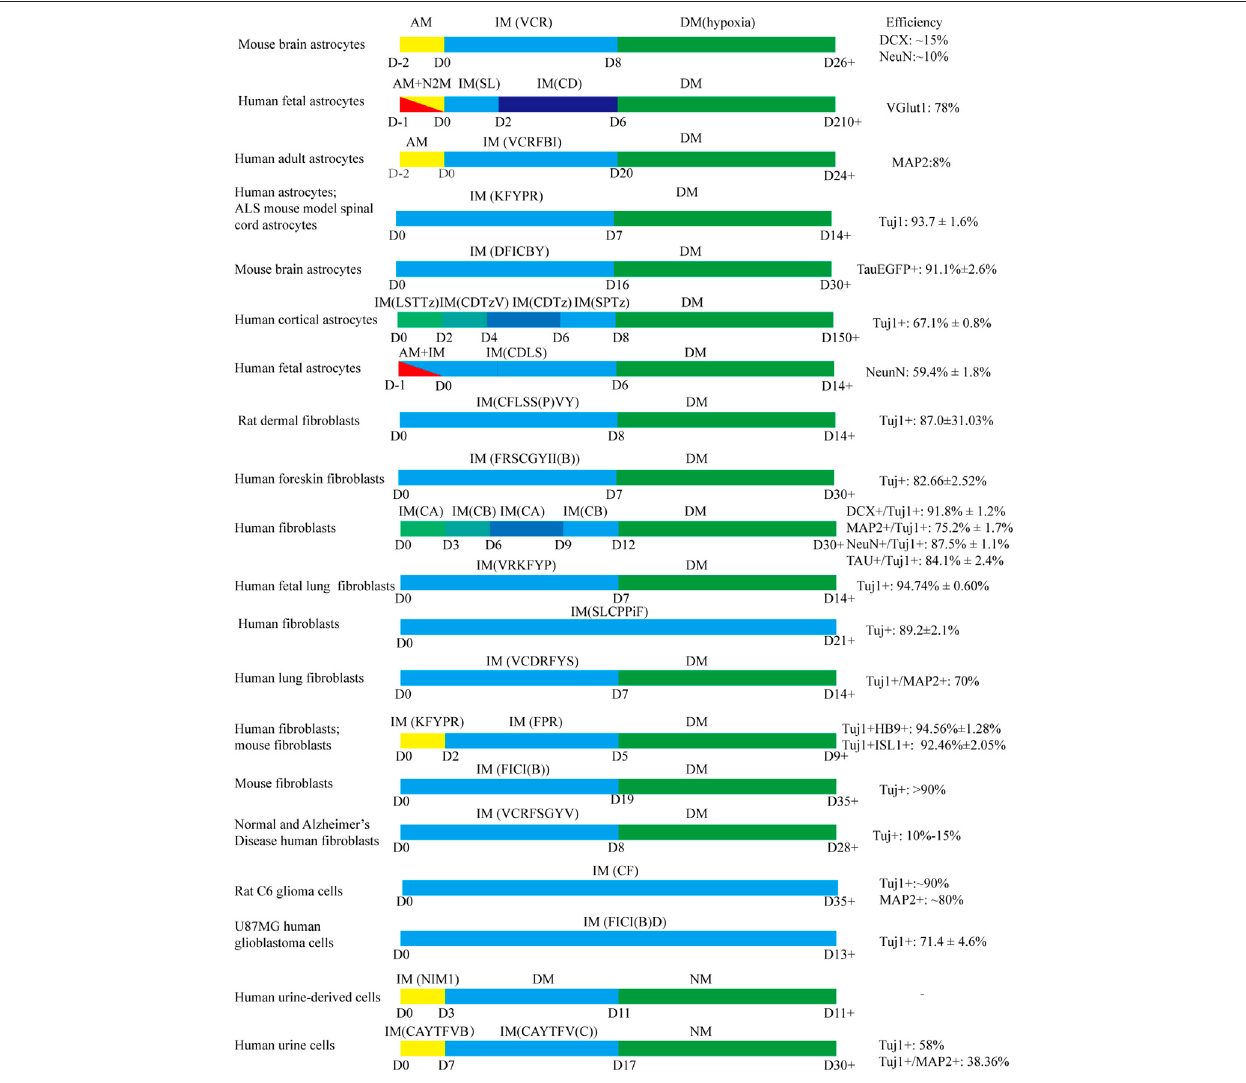
FIGURE 5 | The common protocols use small molecules to generate iNs. AM: astrocyte medium; IM: induced medium; DM: differentiation medium; N2M: N2 medium; NM: neuron medium VCR: VPA, Chir99021, Repsox; SL: SB431542, LDN193189; CD: CHIR99021, DAPT; VCRFBI: VPA, Chir99021, Repsox,